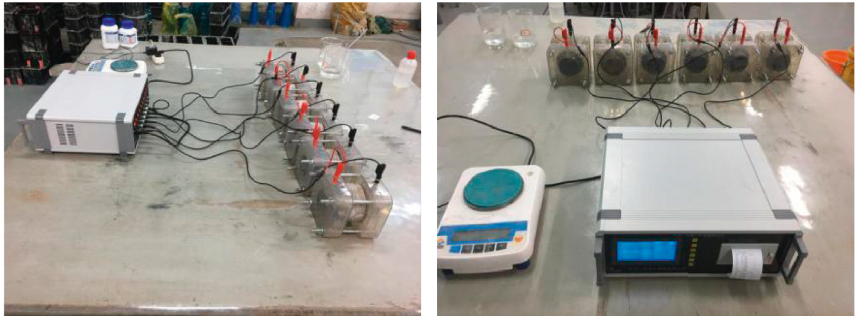
Figure 7: Electric flux testing process.